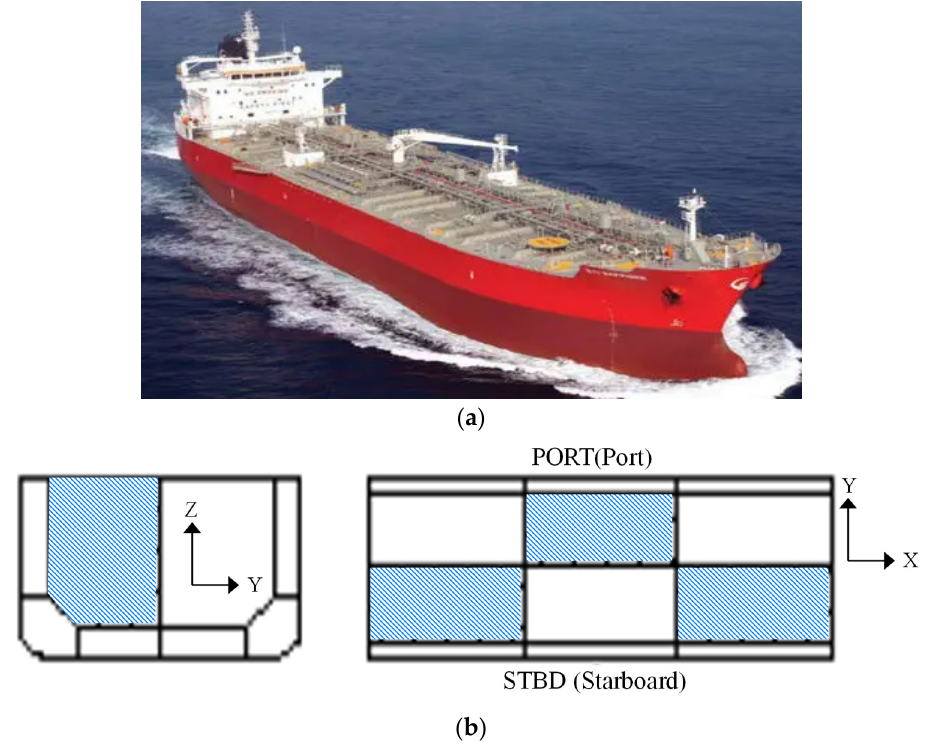
Figure 1. Typical product carrier and zig-zag loading pattern during tank test. ( a ) Typical product carrier; ( b ) zig-zag loading in the cargo hold.